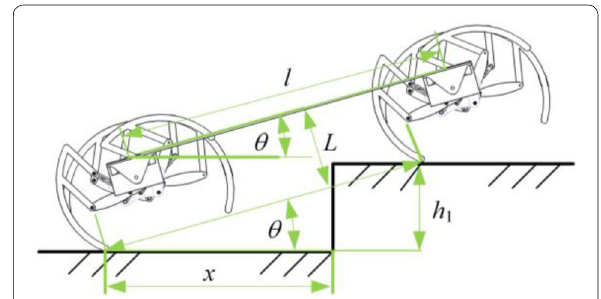
Figure 9 Frame size